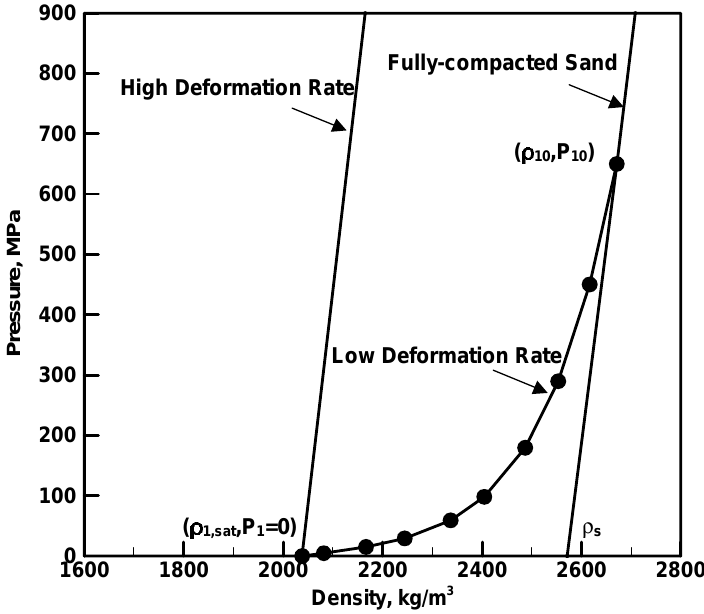
Fig. 2. Pressure vs. density relations for saturated sand at low and high deformation rates proposed in the present